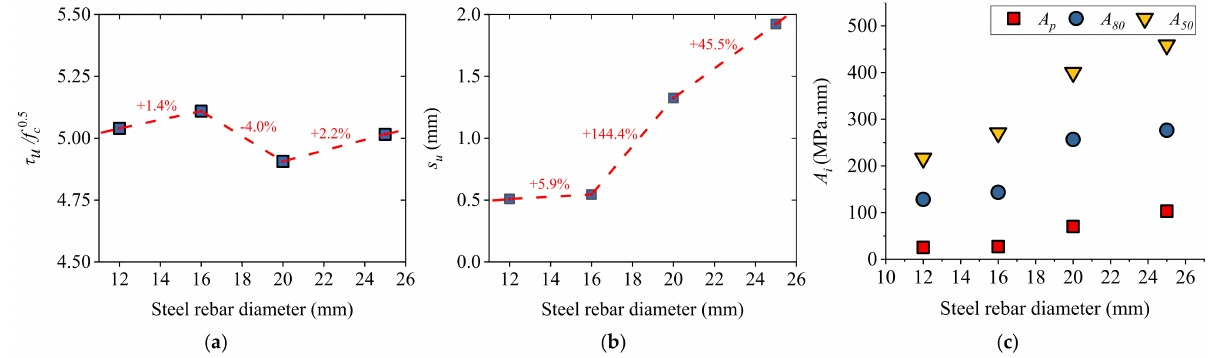
Figure 11. Effect of rebar diameter on bond performance: ( a ) bond strength; ( b ) peak slip; ( c ) bond toughness.